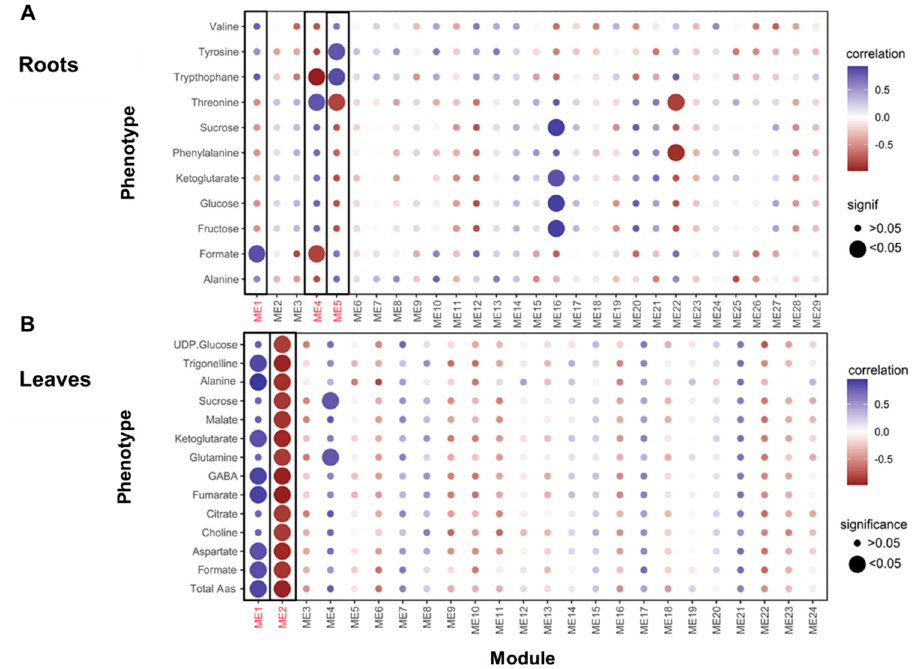
Figure 6. Correlation of metabolites showing significant changes in contents to N supply with co-expression clusters of genes expressed in roots ( A ) and leaves ( B ). Co-expression network analysis was performed using the GWENA tool [69] withnormalized expression data obtained from the DESeq2 package. Modules with a significant overlap with the DEGs ( p -value < 0.05) are highlighted with a black square and red letters.